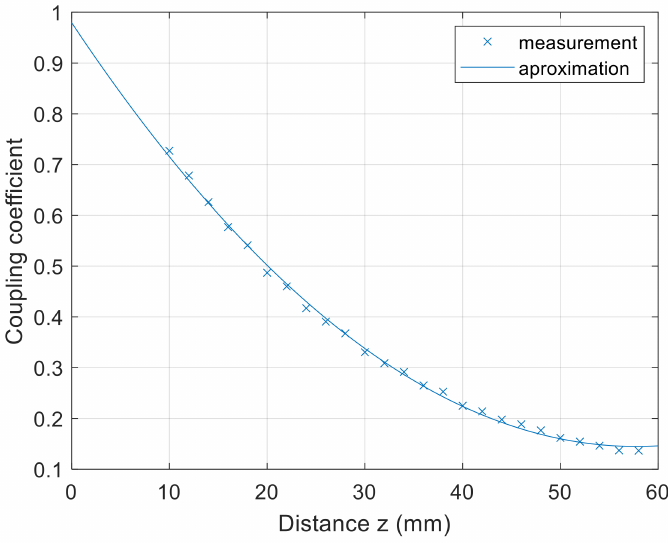
Figure 8. Coils under test. ( a ) Square planar coil, ( b ) planar DD coil.